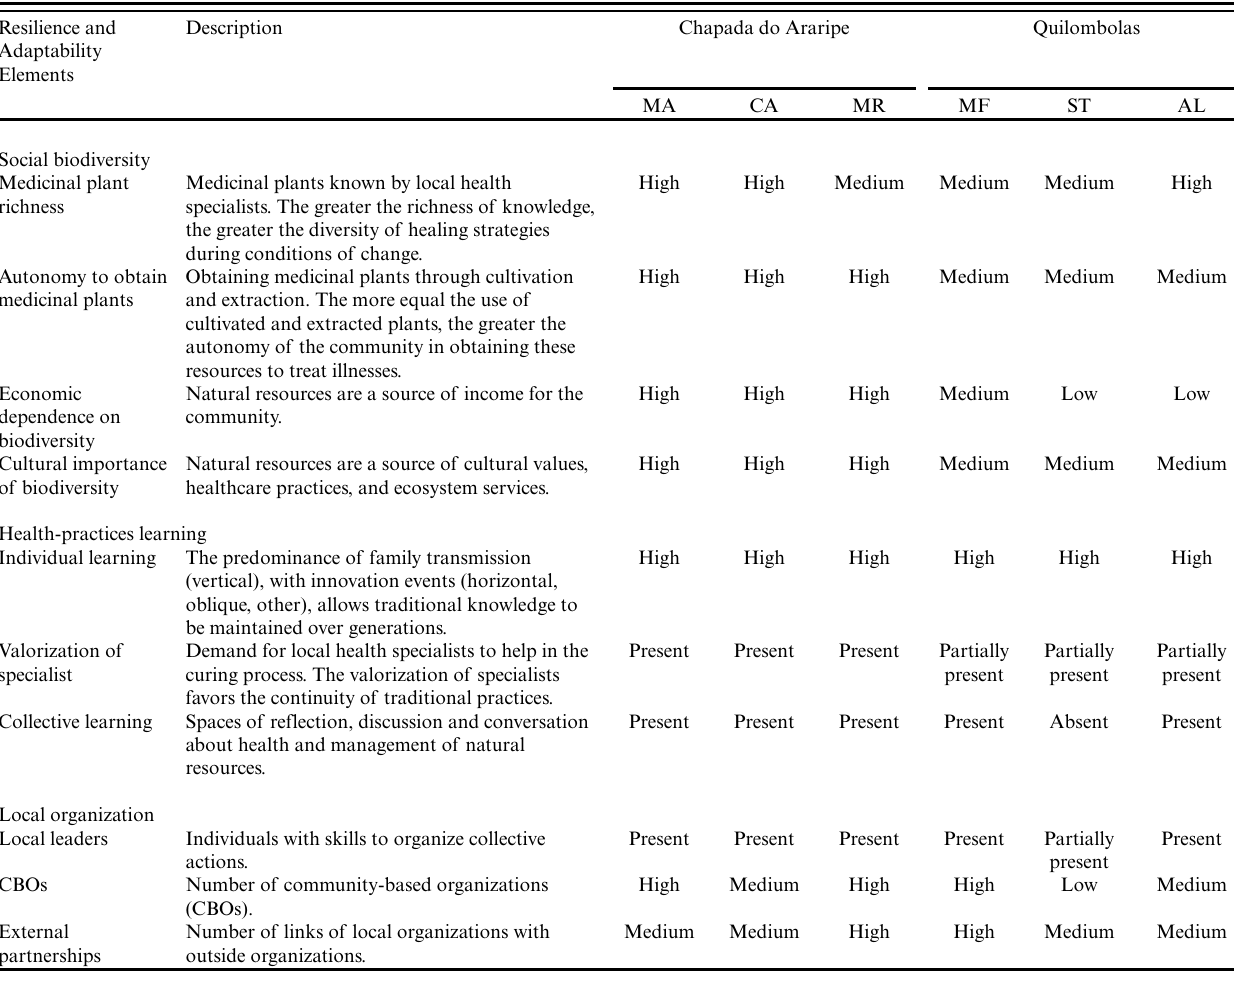
Table 2 . Elements of adaptive capacity and resilience based on traditional health services (THS) components (social biodiversity, learning, and social organization) in the Araripe and Quilombola communities. MA = Macaúba, CA = Cacimbas, MR = Maracujá, MF = Morro do Fortunato, ST = Santa Cruz, AL =